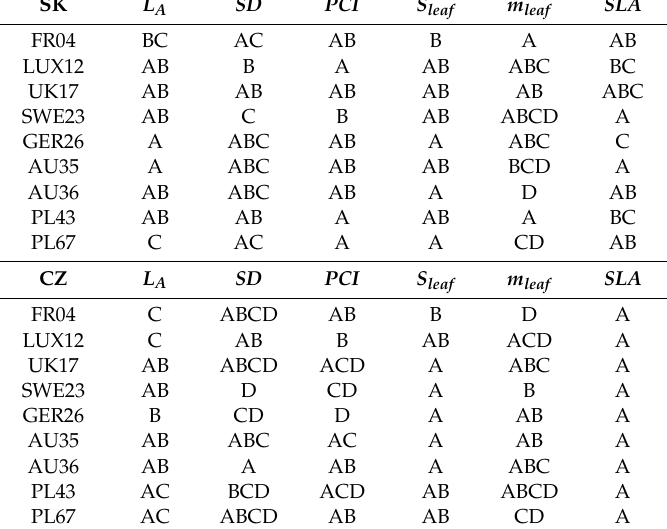
Table A1. Results of Fisher LSD post-hoc